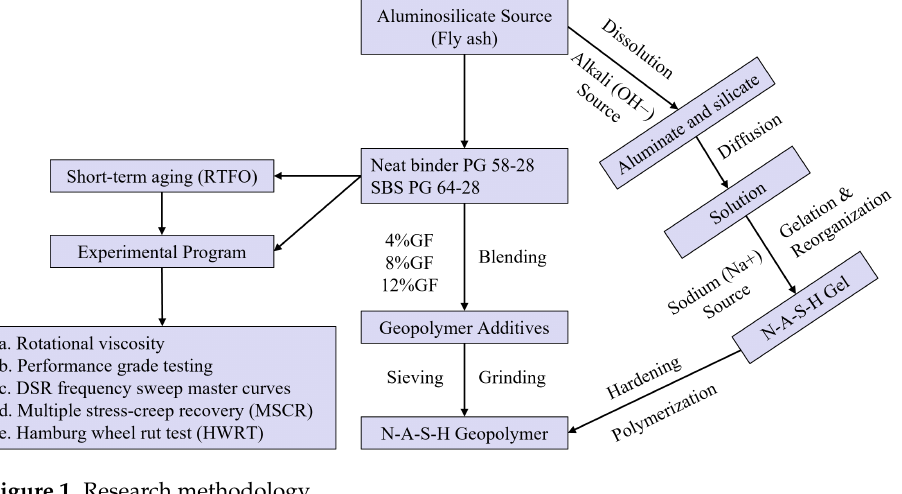
Figure 1. Research